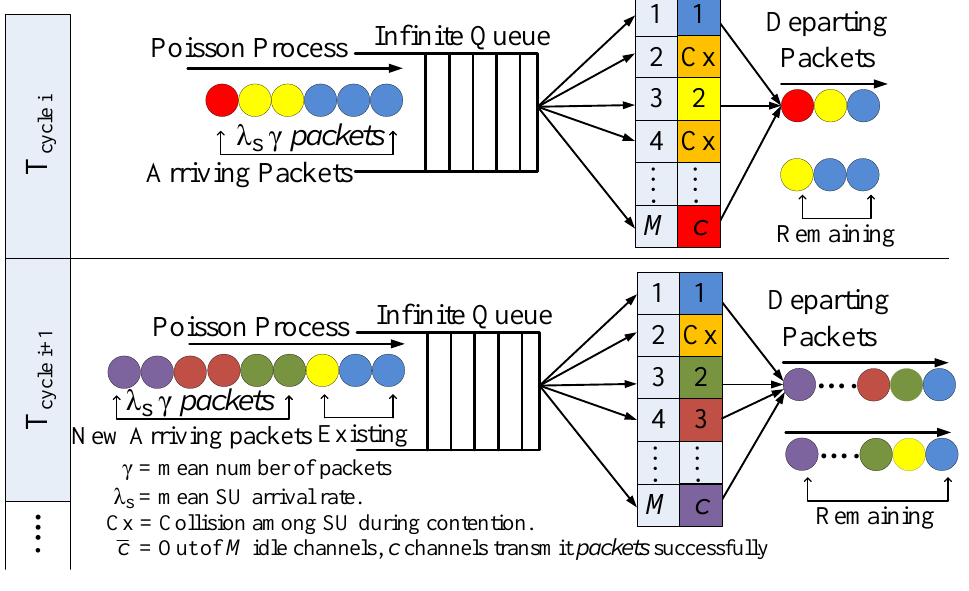
Figure 2. PRI-M/M/c queuing model of secondary